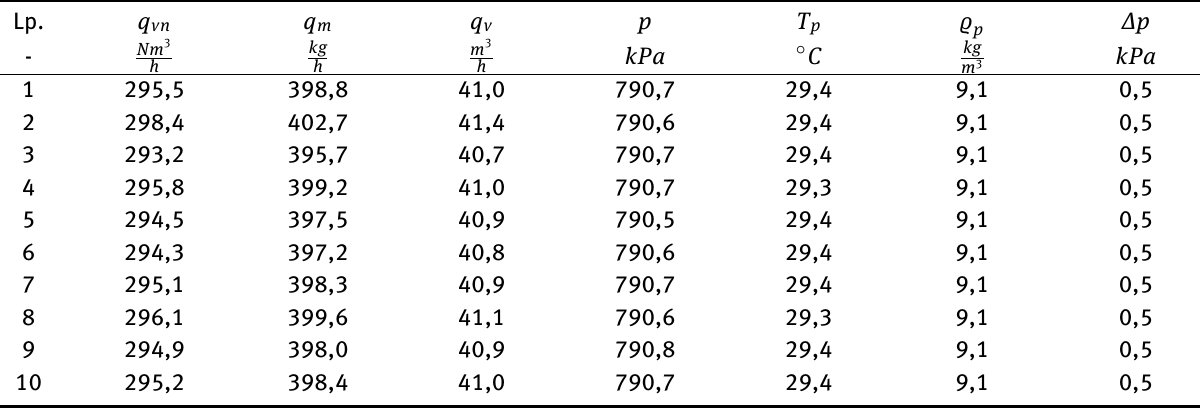
Table 2: Table of recorded results Lp.